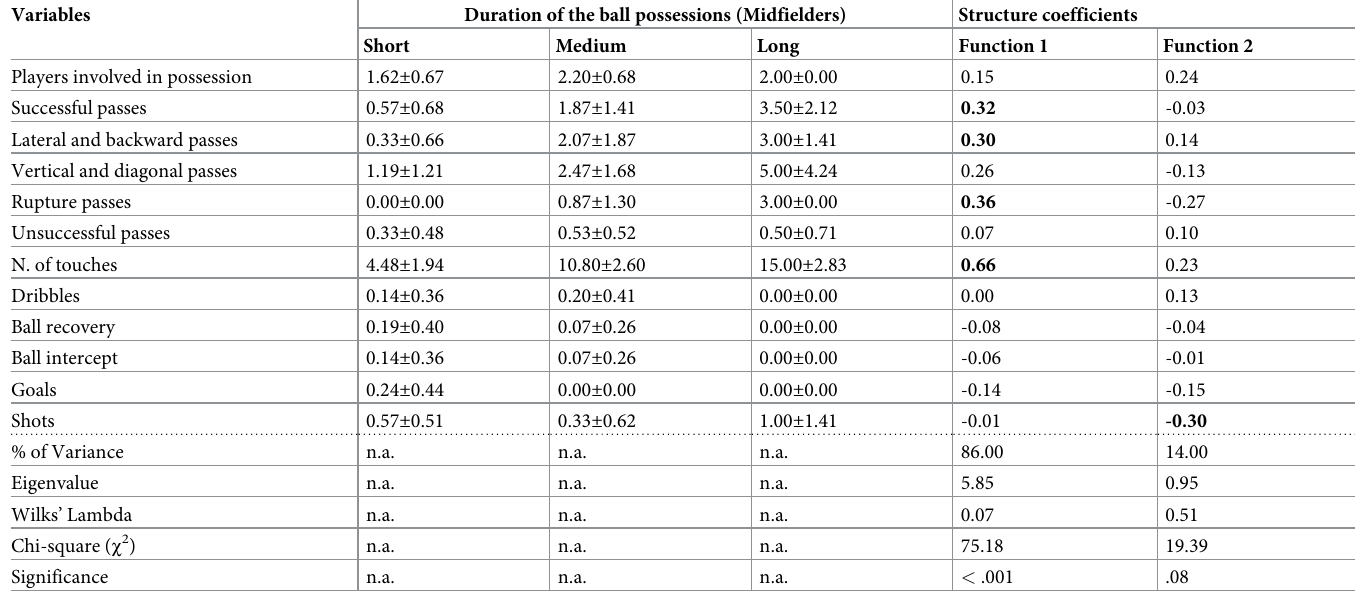
Table 3. Means ( ± SD), discriminant function details and structure coefficients for the three clusters according to the midfielders game scenarios. Variables Duration of the ball possessions